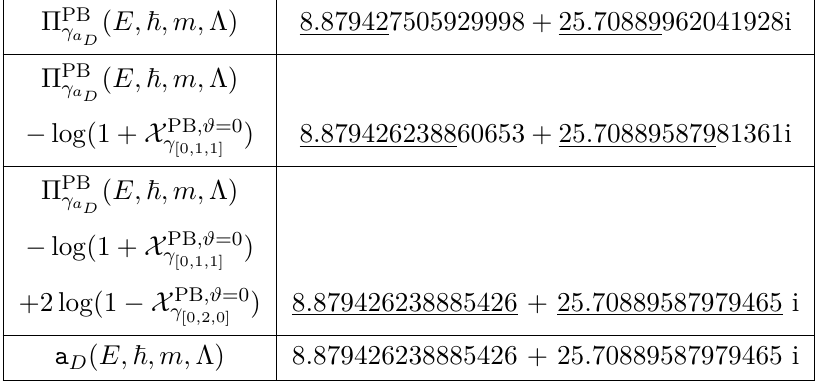
Table 3 . Transformation to compare Padé-Borel summation Π PB The parameters used are E = 4 , m = 0 , Λ = 1